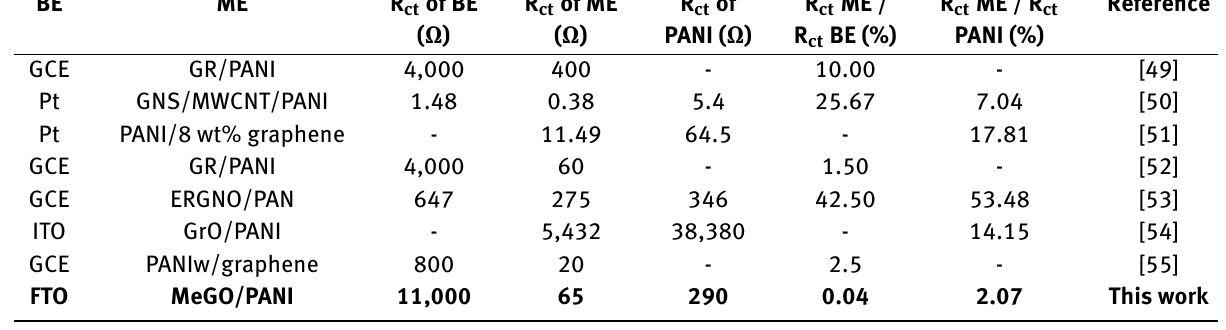
Table 2: Comparing R ct of bare, PANI and modified electrode at this work with several recently published reports BE